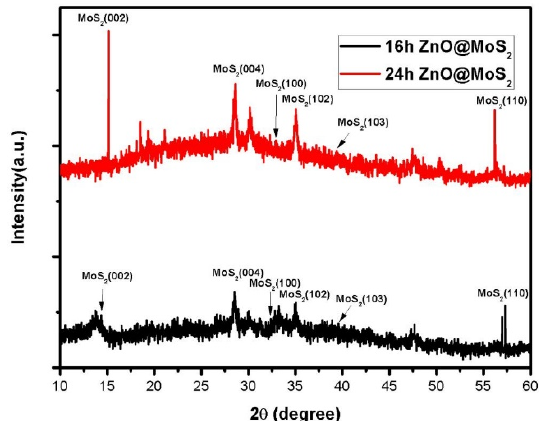
Figure 5. X-ray di ff raction pattern of samples at 16 h and 24 Figure 5. X-ray diffraction pattern of samples at 16 h and 24 h. Figure 5. X-ray diffraction pattern of samples at 16 h and 24 h.